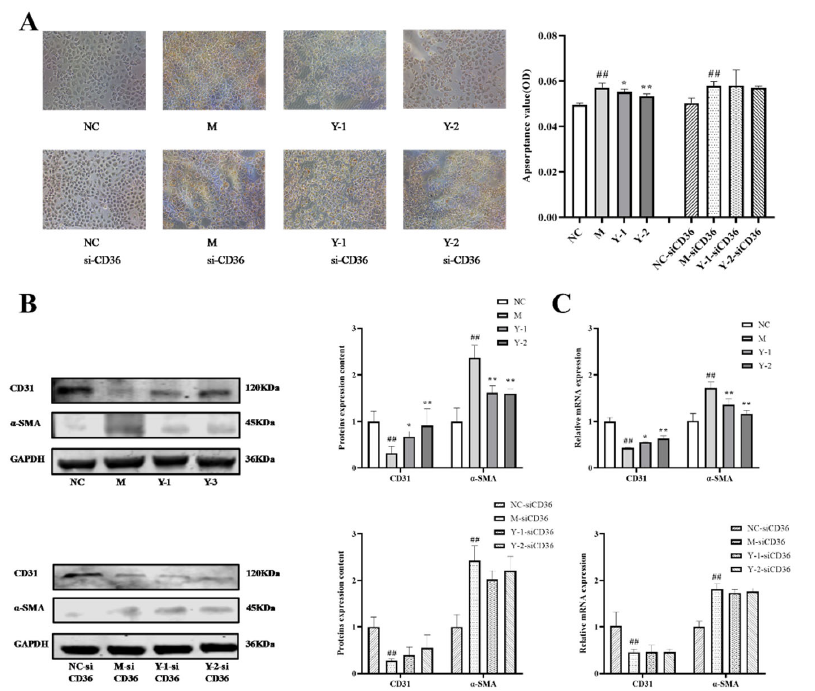
Figure 6. Effects of Y ‐ 1 and Y ‐ 2 on lipid deposition and EMT of NRK ‐ 52e cells stimulated by sodium oleate with/without CD36 silencing. Effect of sodium oleate on lipid accumulation in NRK ‐ 52e cells detected by Oil Red O staining ( A ). The expression of CD31 and α‐ SMA proteins in NRK ‐ 52e cells were quantified by Western blot and normalized ( n = 3) ( B ). The expression of CD31 and α‐ SMA mRNA in NRK ‐ 52e cells were quantified by qRT ‐ PCR and normalized ( n = 3) ( C ). Compared with NC or NC ‐ sicD36 group, ## p < 0.01; compared with M or M ‐ sicD36 group, * p < 0.05, ** p < 0.01.